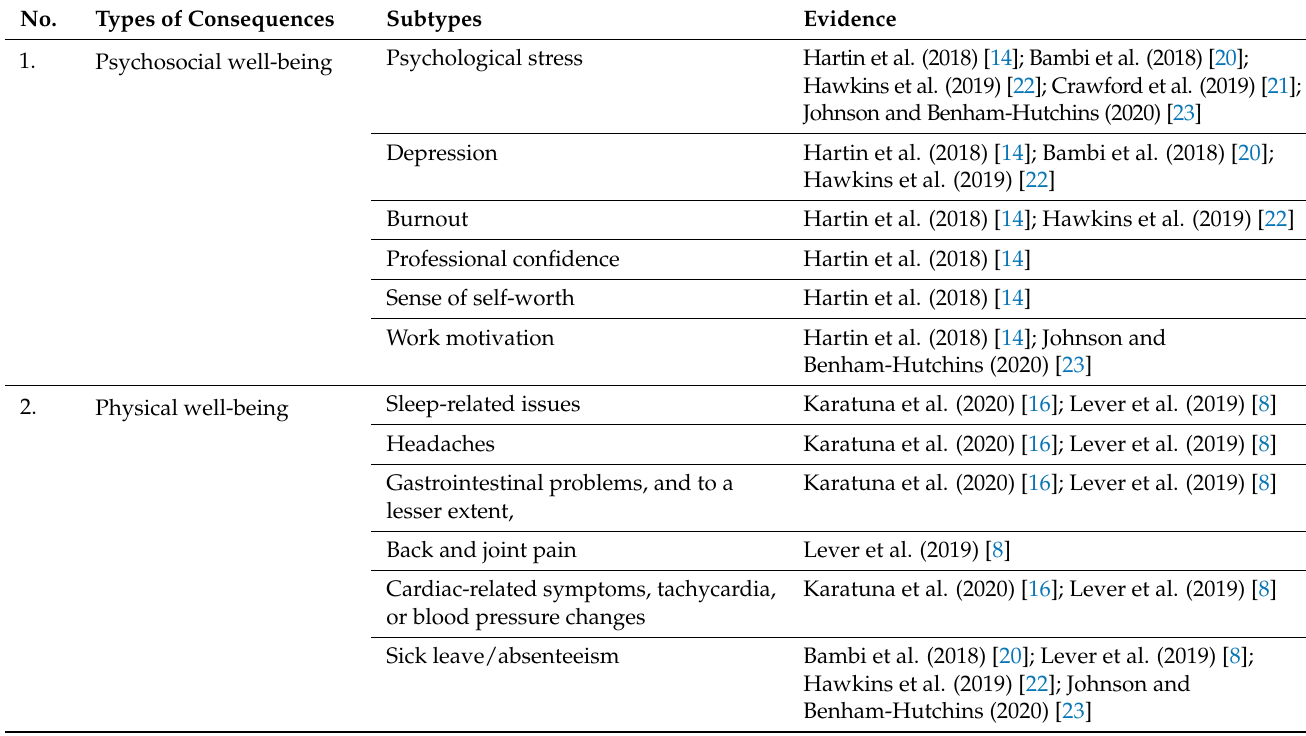
Table 5. Summary table of consequences of workplace